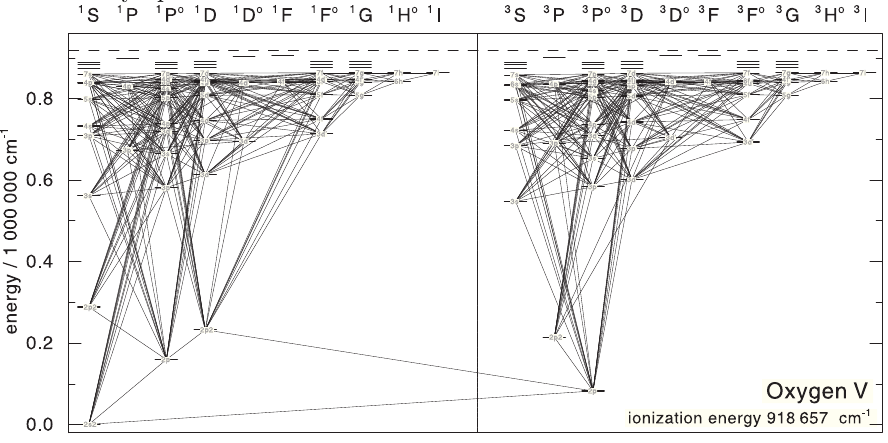
Fig. 5. Grotrian diagram of O V